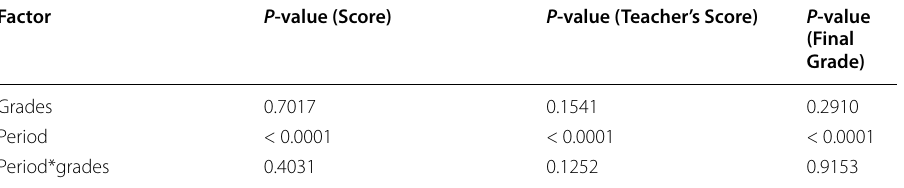
Table 3 Multifactorial dispersive analysis of the index Score, Teacher’s Score, and Final Grade with influence factors: grades, period, and period and grades